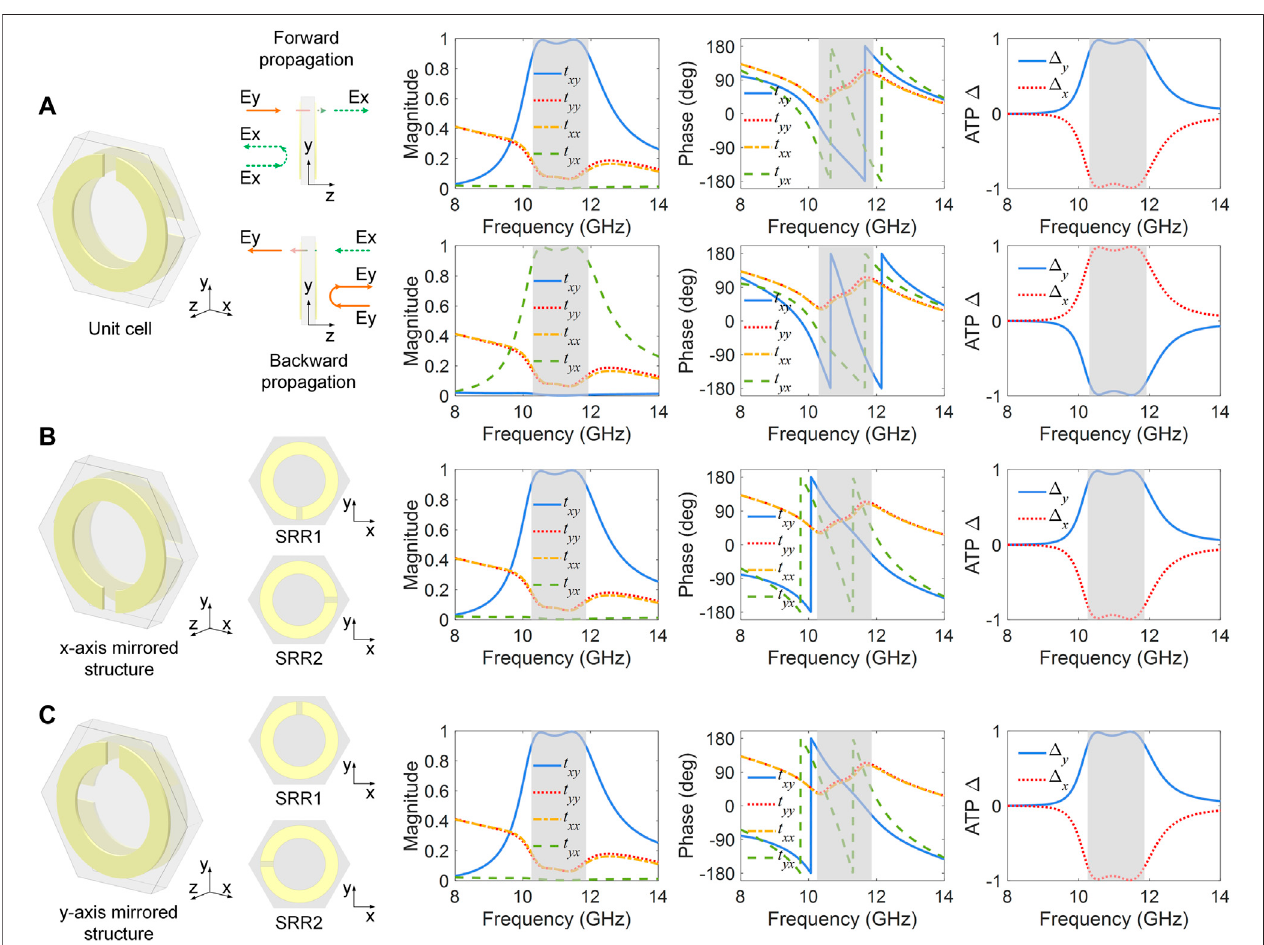
FIGURE 4 | (A) Asymmetric propagation schematic of unit cell (parameters: r (cid:1) 4.2 mm, w (cid:1) 1.4 mm, g (cid:1) 0.6 mm) and its corresponding simulated results and asymmetrytransmissionparameter(ATP) results,thegrayregionisthebandwhose| t xy |or| t yx |isover0.9. (B) X-axisand (C) y-axis mirroredstructuresand theirforward propagation results and ATP